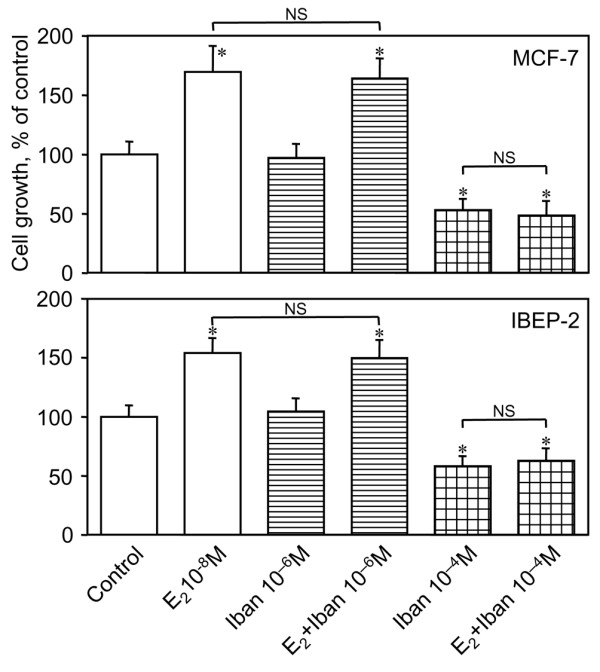
Effects of ibandronate (Iban) on the stimulation of MCF-7 and IBEP-2 cell growth induced by 17β-estradiol (E2). Cells were incubated with 10-4 M Iban and/or 10-8 M E2 or vehicle (control) for 3 days. Cell growth determination was performed after three days as described in Fig. 1. Asterisks indicate ANOVA p < 0.01 versus control, Tukey post hoc test. NS, not significant.